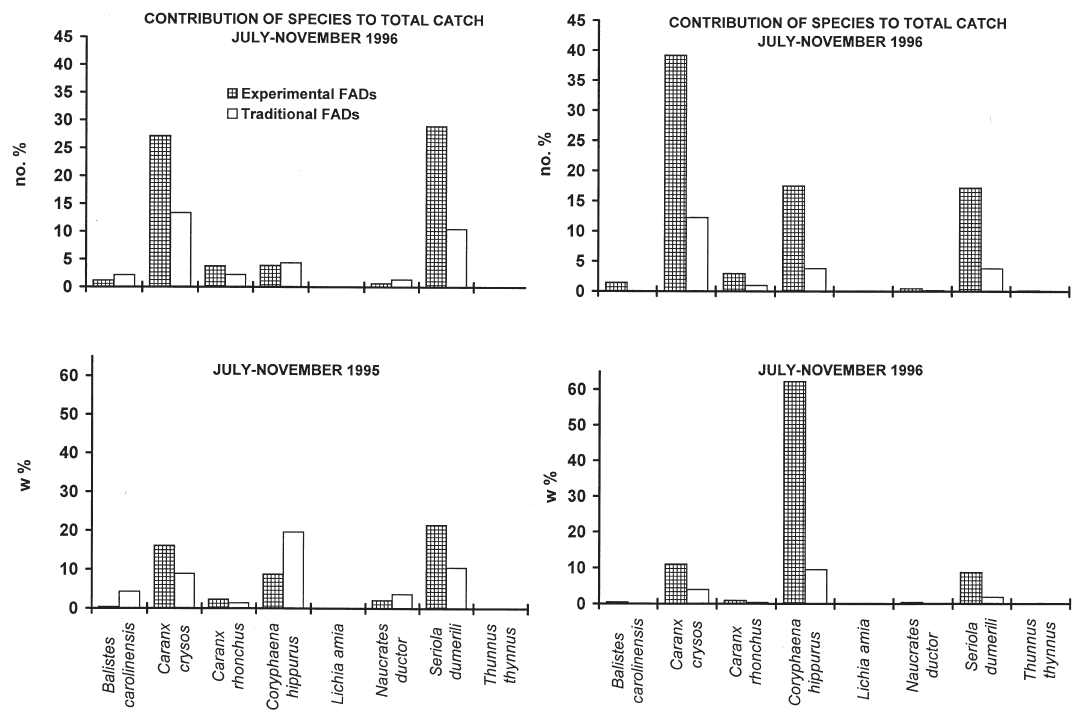
F IG . 5. – Percentage contribution in number of individuals (no.%) and in weight (w%) of each species to the annual total catch around only experimental and traditional FADs.